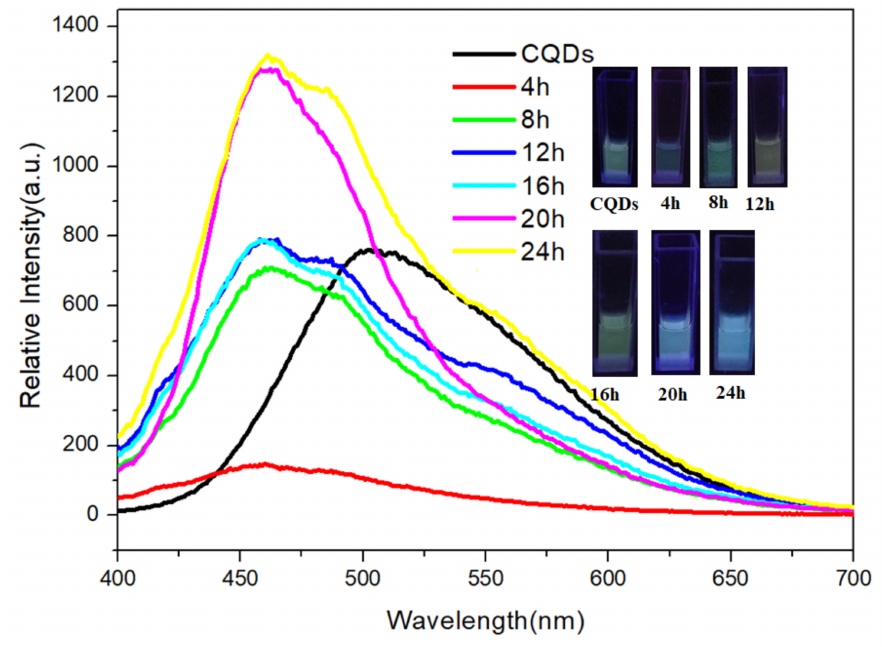
Figure 6. Emission spectra ( λ ex = 365 nm) of CQDs at different time.